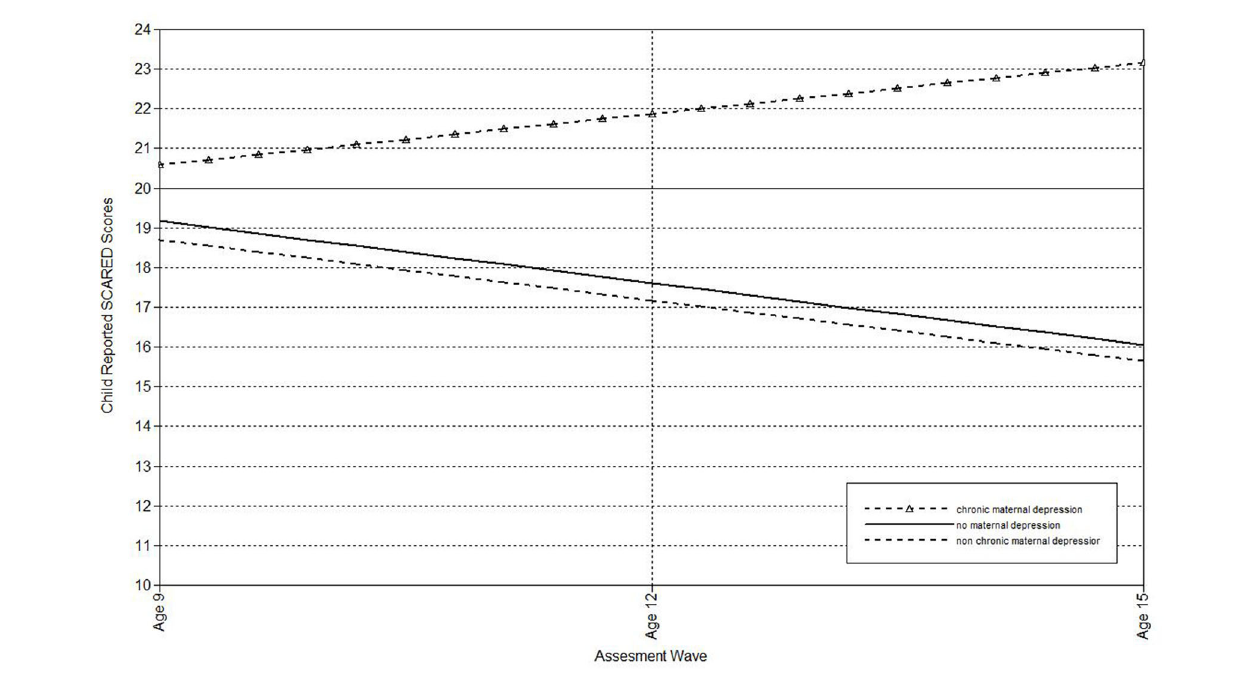
offspring of both non-depressed and non-chronically depressed